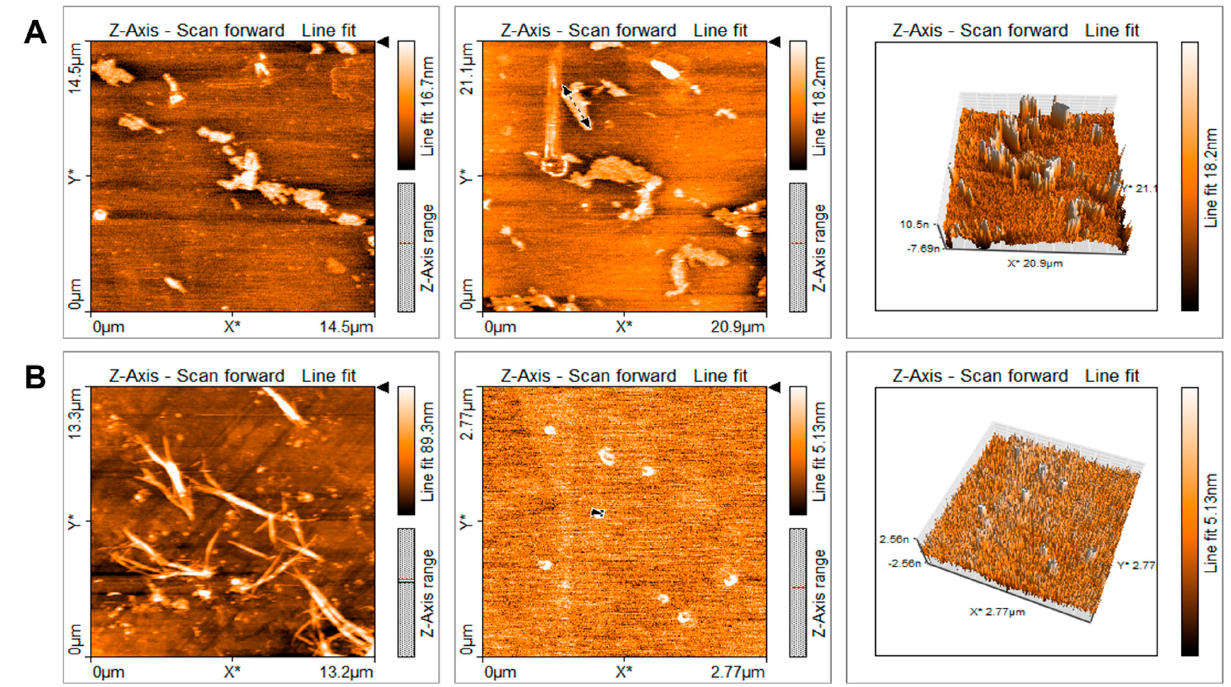
Figure 1. Quercetin nanoparticles characterization, visualization, and comparison with macroparticles. Visualization was made using an atomic force microscope (AFM) and measurement was determined with the Naio software. The average length obtained after three measurements was 35.5 μ m for QMPs ( A ) and 140 nm for QNPs ( B ), 253 times less than macroparticles.